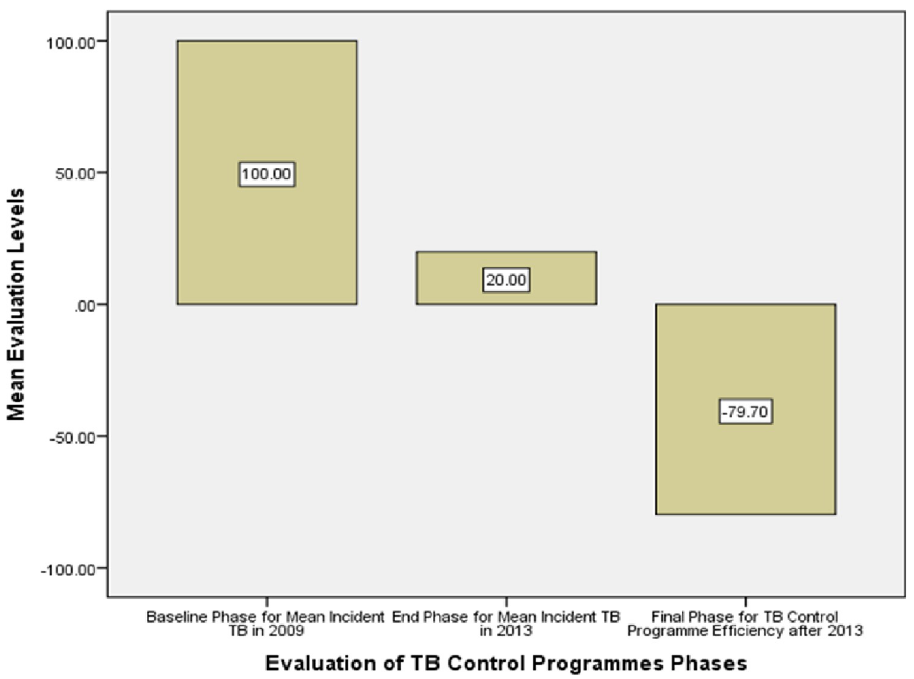
Fig 2. Performance efficiency evaluation of the implementation of TB control program displaying 79.7% reduction of TB incidence over a 5-year period.